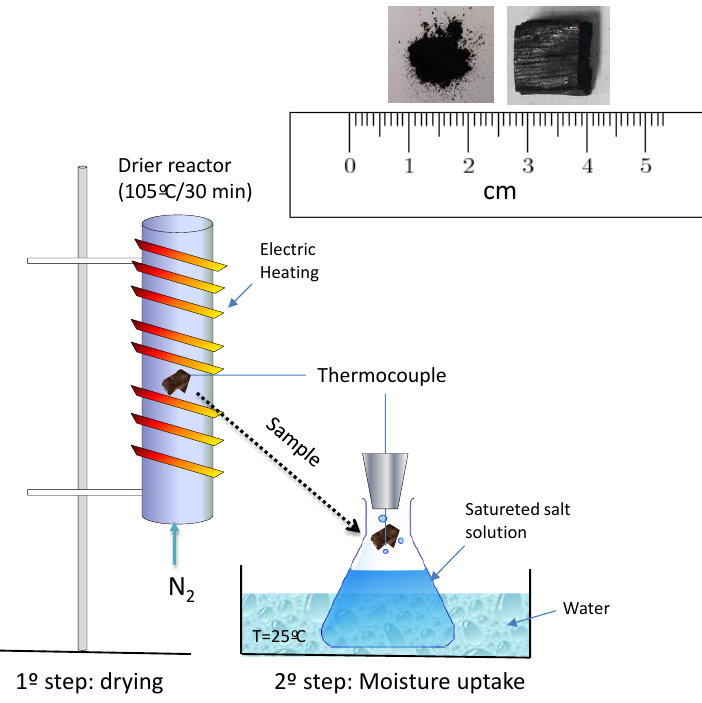
Figure 1. Schematic of experimental setup used for the measurement of temperature change of biomass on exposure to stationary atmosphere (adapted from [2]).